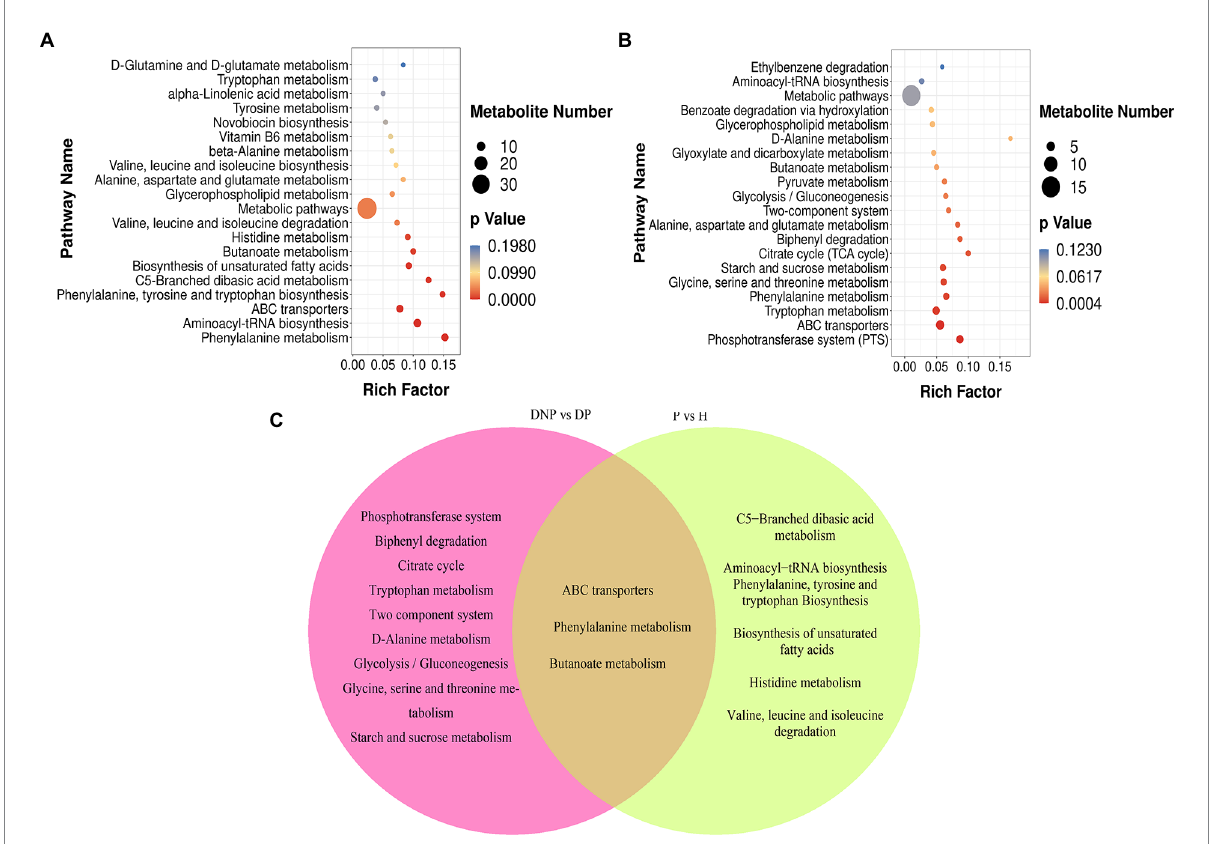
FIGURE 10 KEGG pathway enrichment of differential metabolites (scatter plot). (A–C) KEGG pathway enrichment of differential metabolites including between DNP and DP groups, P and H groups. (C) Left part represents KEGG pathway which were both differential pathway between the DP and DNP group, and between the P and H groups. Besides, intersections represent KEGG pathway were differential pathway between the DP and DNP group only; in addition, Right part represents KEGG pathway were only differential pathway between the P and H groups only. The results of KEGG enrichment analysis using ggplot2 are shown in a scatter map. Rich factor = S gene number/B gene number. The left name of the pathway, the smaller the p -value, the higher the KEGG